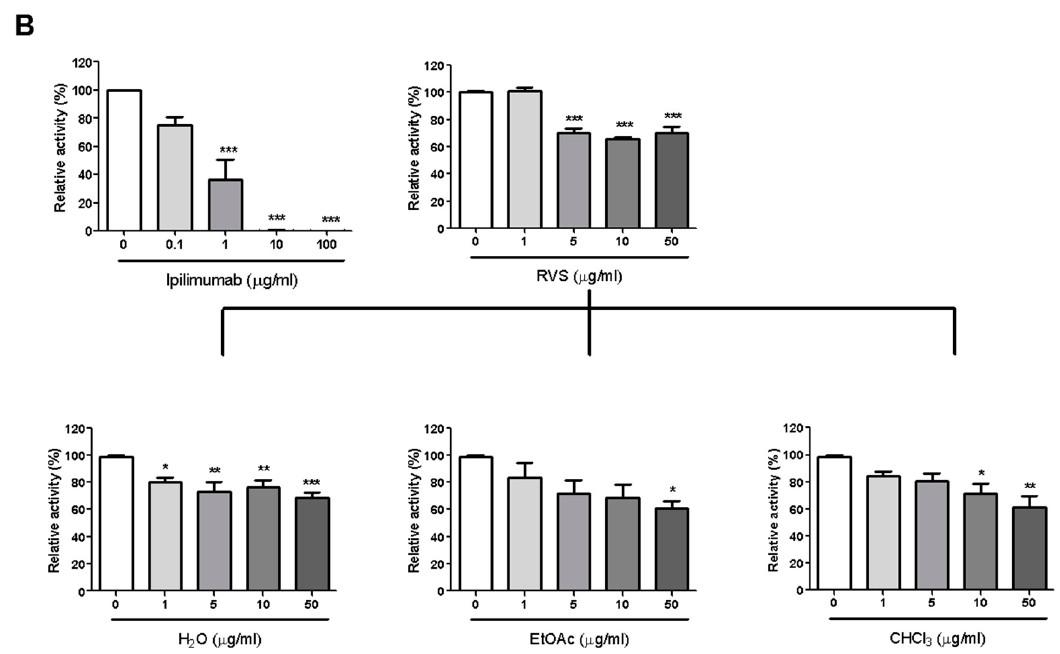
Figure 1. Immune checkpoint blocking e ff ects of Rhus verniciflua Stokes (RVS) extract and fractions tested by competitive Enzyme-Linked Immunosorbent Assay (ELISA). E ff ect of PD-L1 inhibitor C1, RVS extract and fractions on PD-1 / PD-L1 binding activity ( A ); E ff ect of anti-CTLA-4 antibody, RVS extract and fractions on CTLA-4 / CD80 binding activity ( B ). The relative binding activity was normalized to the relative percentage of the vehicle control group. Half-maximal inhibitory concentration (IC 50 ) was calculated using Prism “log[inhibitor] vs. normalized response” equation. All results are presented as the mean value of three independent biological replicates. * p < 0.05, ** p < 0.01, *** p < 0.001, compared with the vehicle control